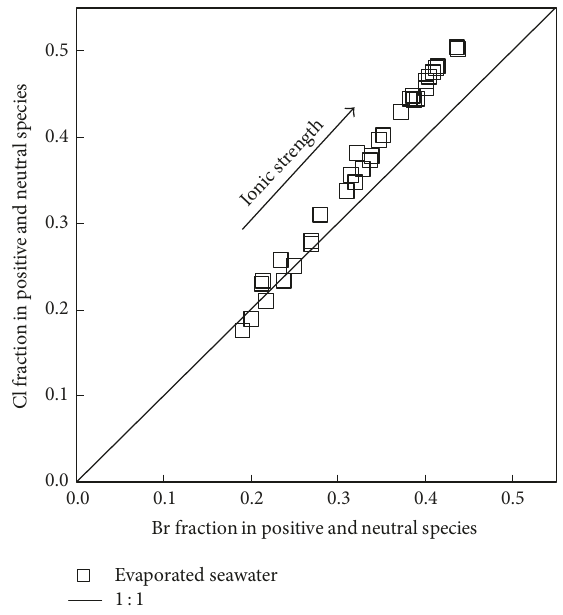
Figure6: Fraction of Cl − and Br − occurringin theformofpositively charged and neutral ion pairs and clusters. Calculations are for seawater, evaporated to variable degrees [31], using 𝐾 from Chen and Pappu [32].